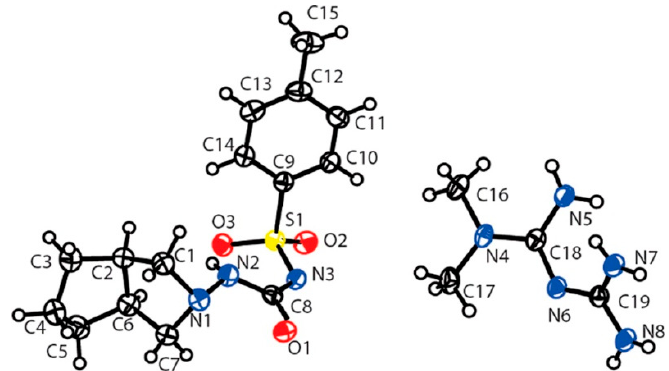
Figure 28. Asymmetric unit containing MET ( right ) and GLI ( left ) molecules drawn at 50% probability level. Adapted with permission from Crystal Growth & Design , 2016, 16 , 3577–3581. Copyright 2016, American Chemical